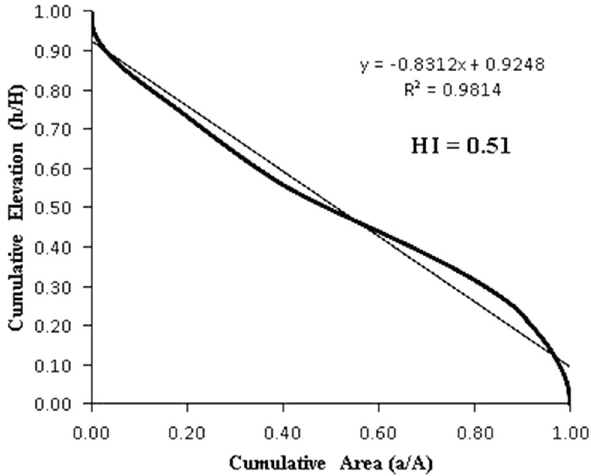
Fig. 5 Hypsometric curve for Dhanari